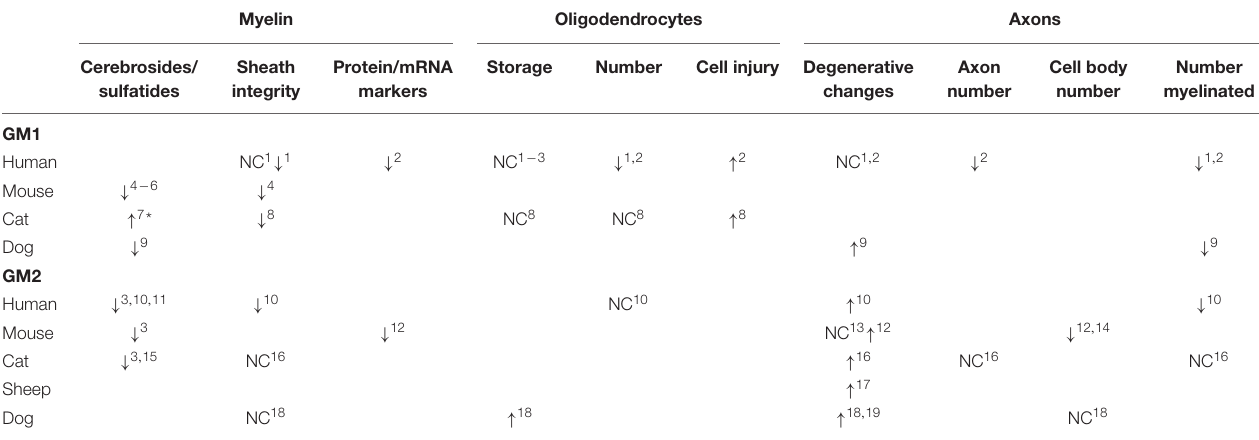
TABLE 1 | Trends in pathological changes to oligodendrocytes, axons, and myelin in GM1 and GM2 gangliosidosis. Myelin Oligodendrocytes Axons Cerebrosides/ Sheath Protein/mRNA Storage Number Cell injury Degenerative sulfatides integrity markers